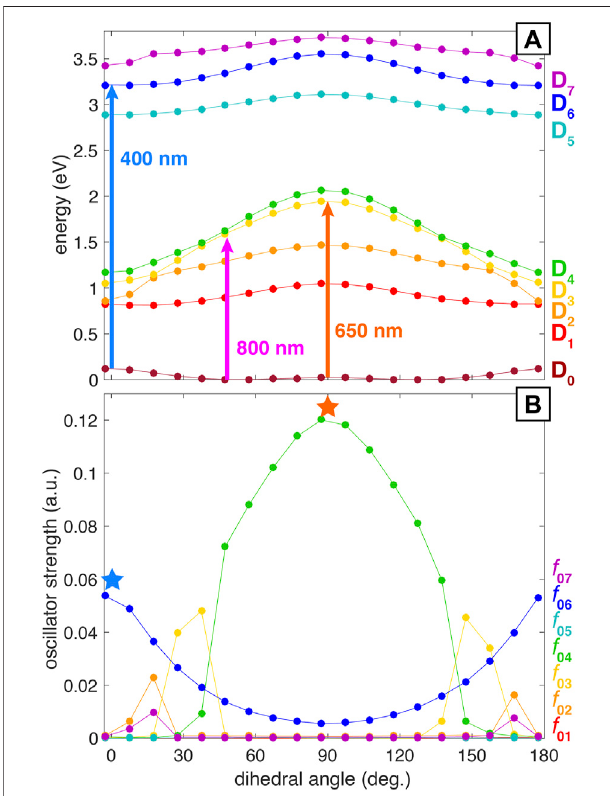
FIGURE 4 | Computed potential energy surfaces (A) and oscillator strengths (B) for PNT + along the C – C – N – O dihedral angle.